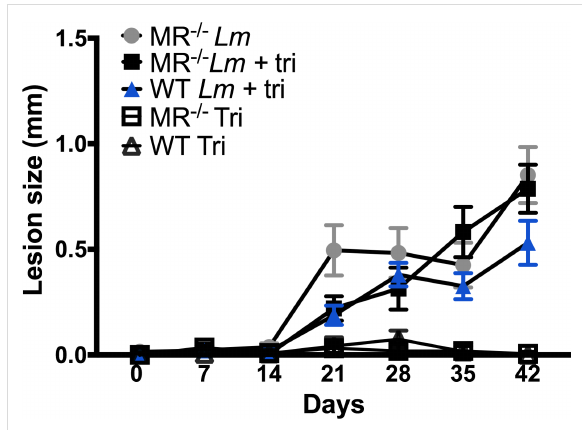
Figure 4: Trimannose-linked bioerodible microparticle 2 treatment of Leishmania major infected wild-type and mannose receptor deleted C57BL/6 mice reduces footpad lesion size. Footpad lesion size is in millimeters for wild-type (WT) and mannose receptor deleted (MR − / − ) mice inoculated with L. major alone ( Lm , grey circle MR − / − ), L. major and trimannose bioerodible microparticles 2 ( Lm + tri: blue triangle WT, black square MR − / − ), or trimannose bioerodible microparticles 2 alone (Tri: unfilled squares MR − / − , unfilled triangles WT). Footpad lesion size was determined by calculating difference between inoculated left hind footpad and non-inoculated right hind footpad. n = 6–10 mice per group. One-way ANOVA with Tukey’s post-hoc